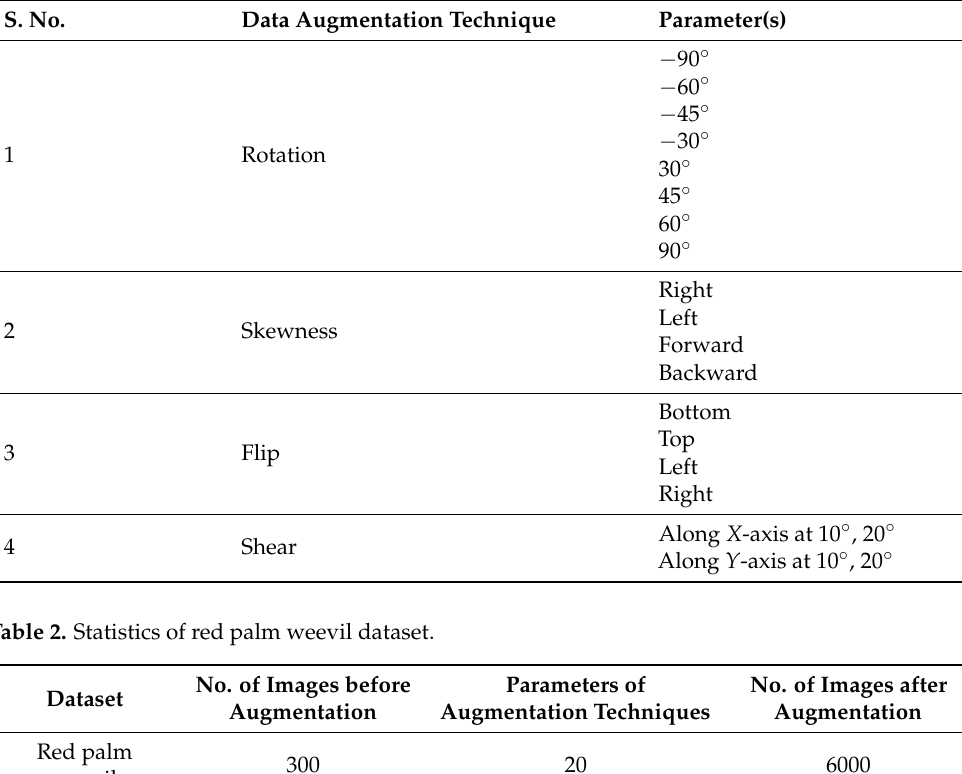
Table 1. Different techniques of data augmentation.